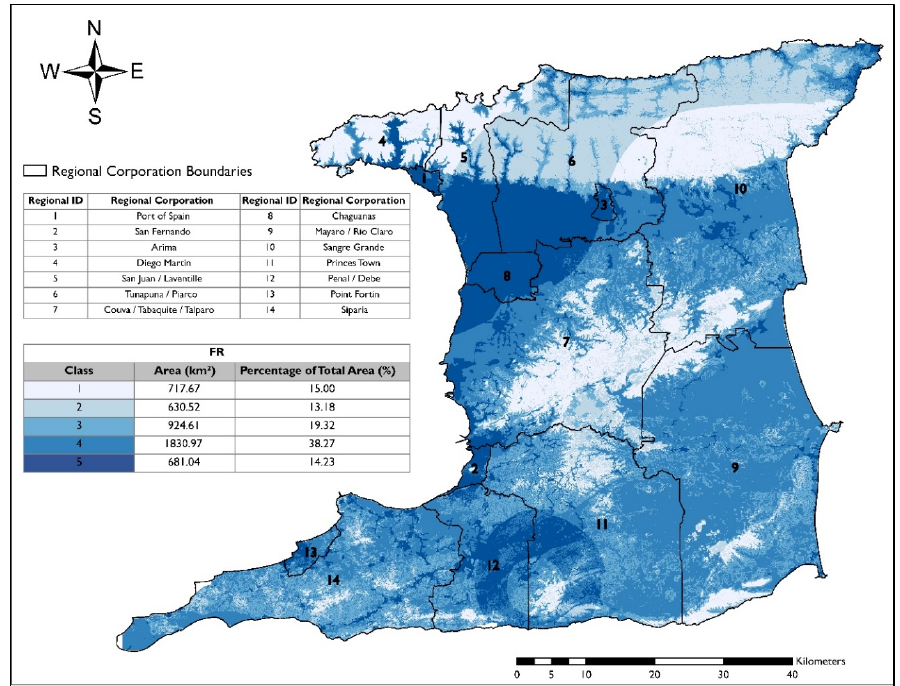
Figure 8. Flood Hazard Indexes created for FR.